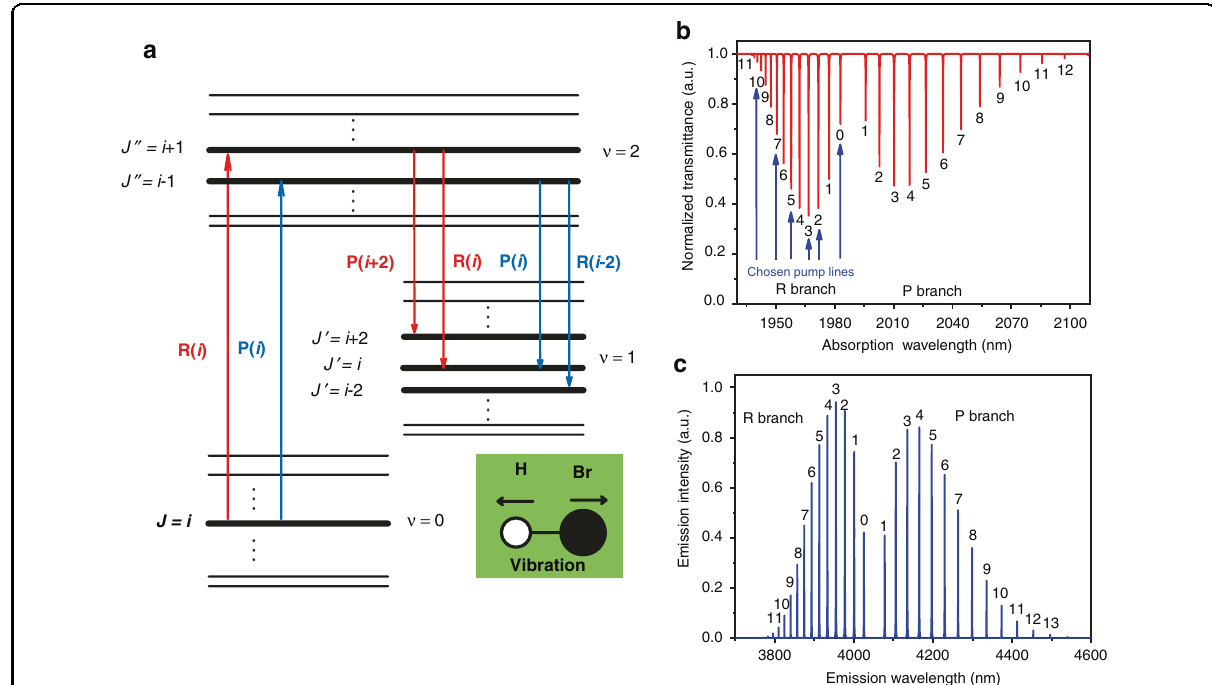
Fig. 2 Characteristics of the radiative transition of the HBr molecule. a Schematic energy level diagram depicting a fi rst-order rotational – vibrational overtone absorption transition and the corresponding laser transitions; inset: the vibrational normal mode of HBr. The small, white- fi lled circle represents the hydrogen atom, and the larger, black- fi lled circle represents the bromine atom; the horizontal line between them represents the electrostatic force, and the black arrows indicate the relative motions of the atoms. b Calculated absorption spectrum of H 79 Br molecules in the 2 μ m spectral region from the HITRAN database 43 . The rotational lines become closer together with increasing rotational quantum number on the R-branch side, while the P-branch lines become more widely spaced as the rotational quantum number increases. The rotational lines marked with blue arrows represent the chosen pump wavelengths. c Corresponding emission spectrum of H 79 Br molecules in the 4 μ m spectral